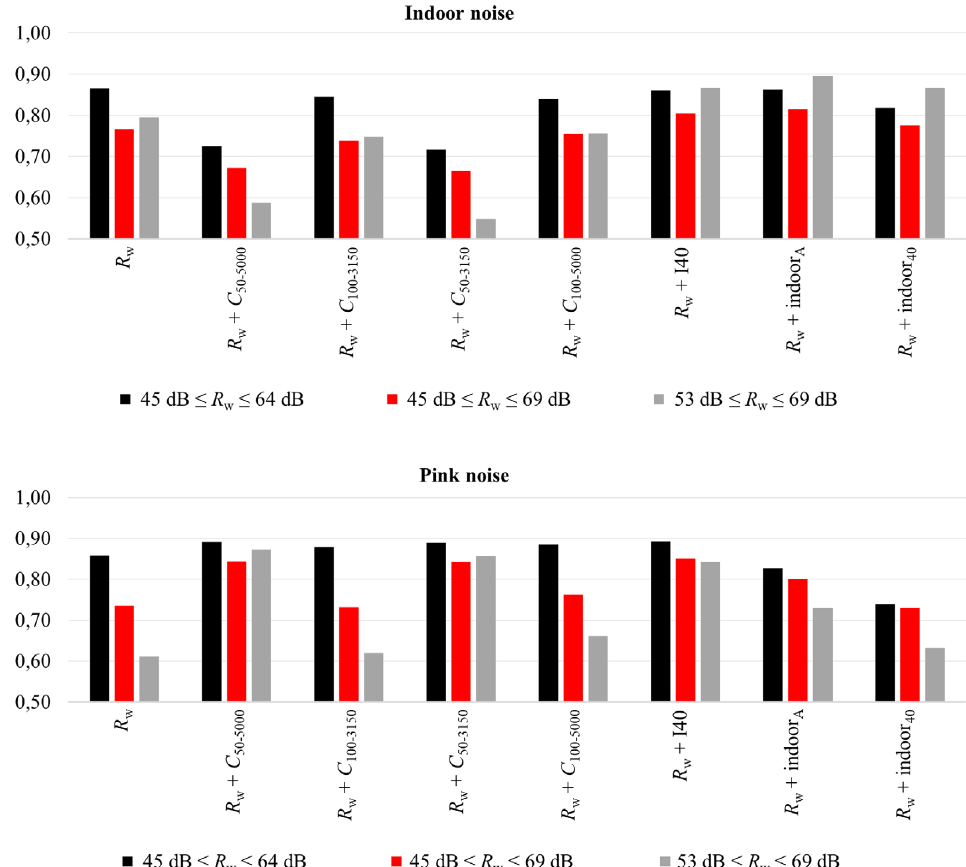
Figure 8. Degree of correlation between SNQ-ranking and transmitted loudness-based ranking, as quanti fi ed by R 2 rank-order correlation, based indoor noise (up) and on pink noise (bottom) as emitted